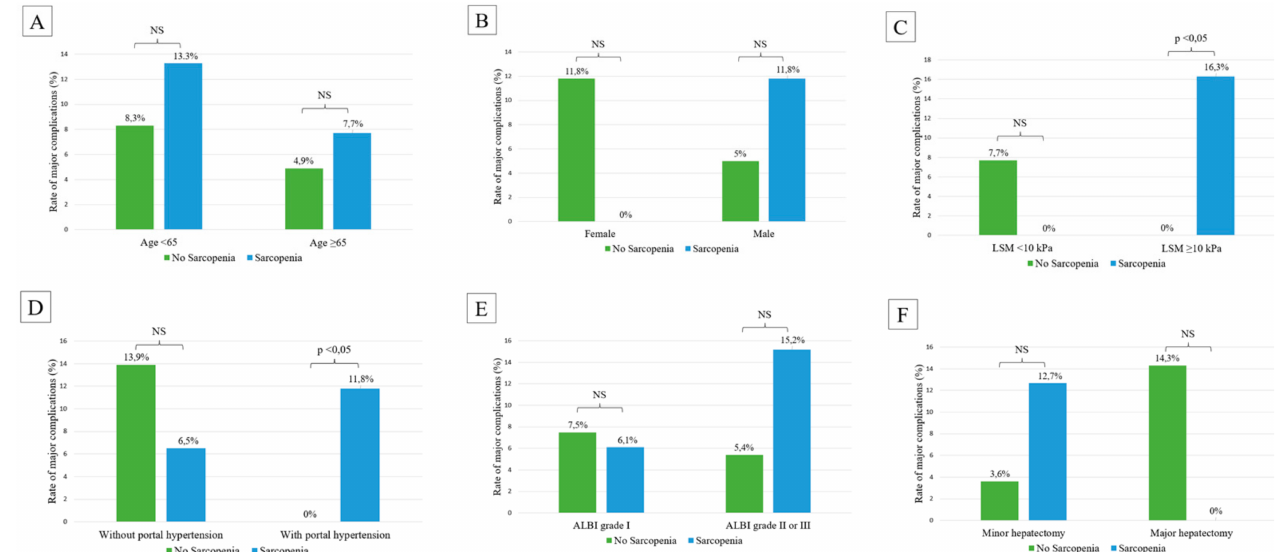
Figure 3. Rate of major complications according to the following sub-groups analysis: ( A ) age, ( B ) gender, ( C ) liver stiffness measurement (LSM), ( D ) portal hypertension, ( E ) albumin-bilirubin (ALBI) grade, ( F ) extent of